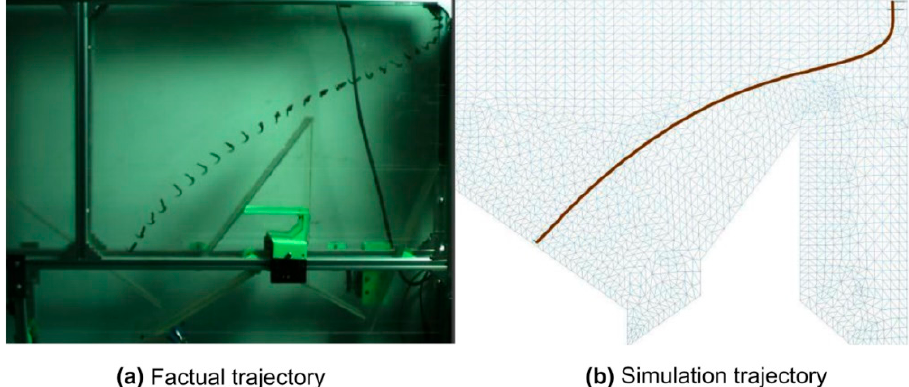
Figure 6. Test trajectory of tea material. ( a ) Actual trajectory captured using a high-speed camera. ( b ) Trajectory tracked by postprocessing software.